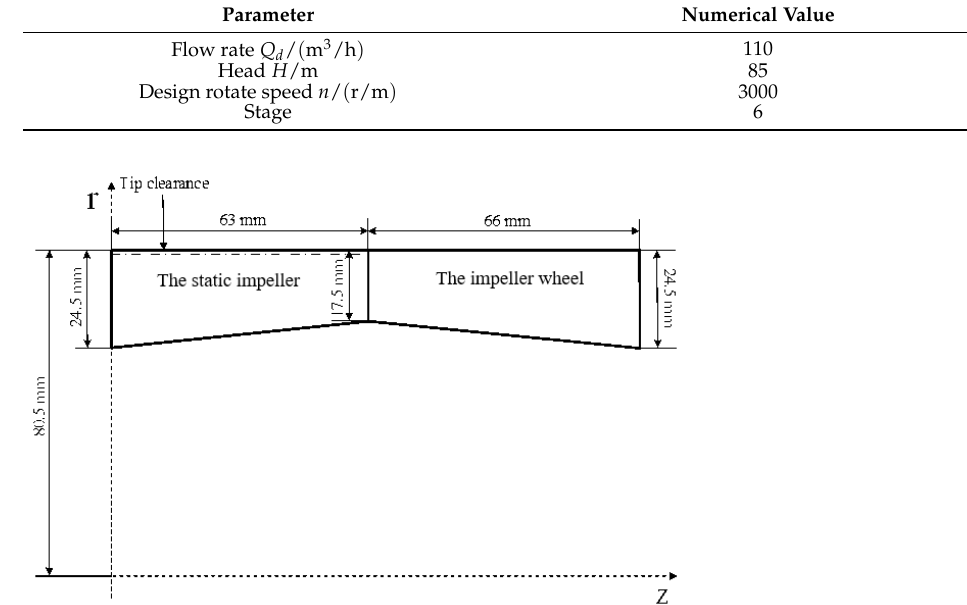
Figure 2. The three-dimensional model of the multiphase pump. 3.2. Mesh Generation and Verification of Irrelevance The Suction Chamber, the extrusion chamber and three pressurizing units are con- sidered as the fluid domains, and each pressurizing unit consists of an impeller wheel and a static impeller. The ICEM software is used to grid, the flow in the suction chamber and the extrusion chamber of the multiphase pump is relatively stable, therefore, an adaptive unstructured is used to grid partition, as shown in Figure 3. However, the flow in the supercharging unit is complex, so the impeller wheel and static impeller of the pump are divided by the structure grid, which are shown in Figure 4.